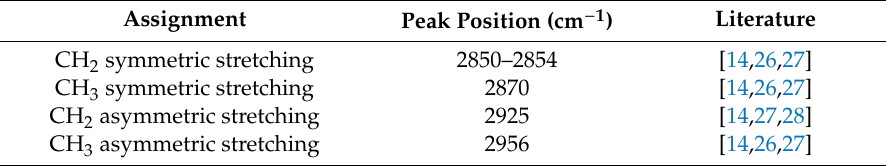
Table 3. Lipids: assignment of lipids and proteins peaks in the spectral region 3000–2800 cm − 1.